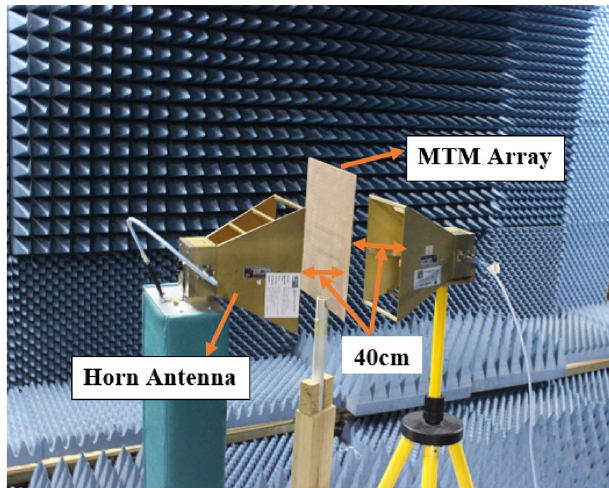
Figure 28. Free space array measurement setup.